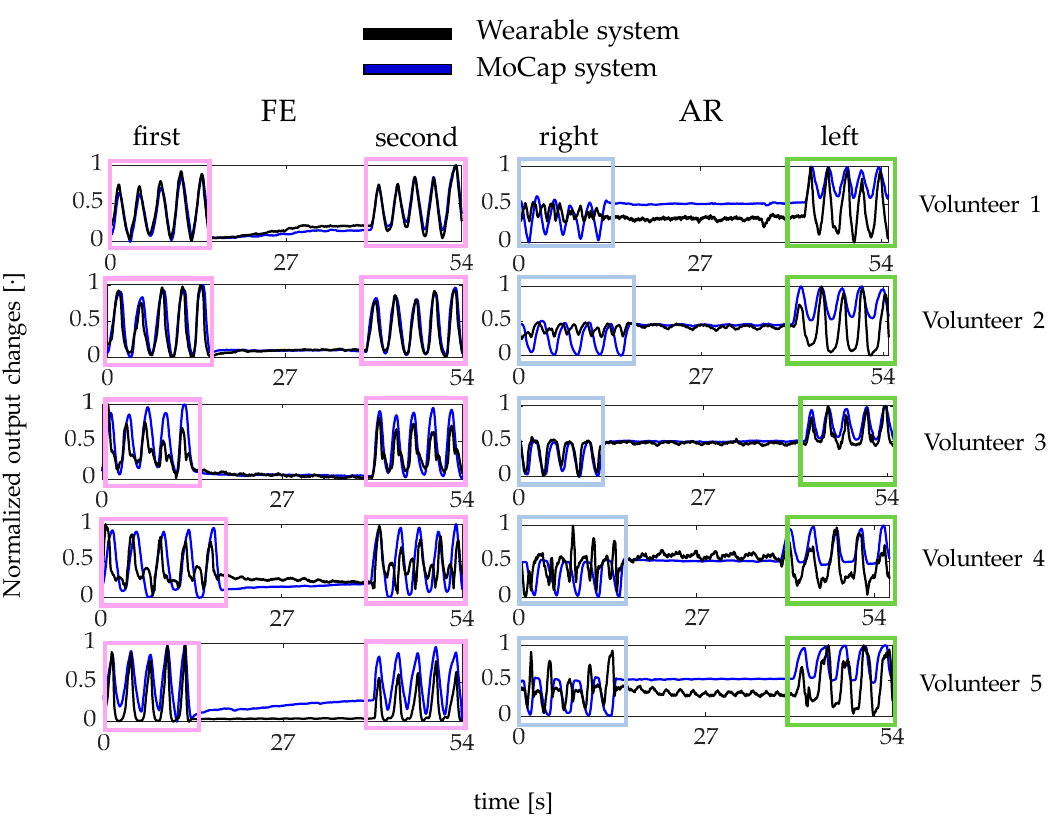
Figure 8. The output changes of both the wearable (black line) and the Motion Capture (MoCap) system (blue line) collected during FE and AR repetitions.